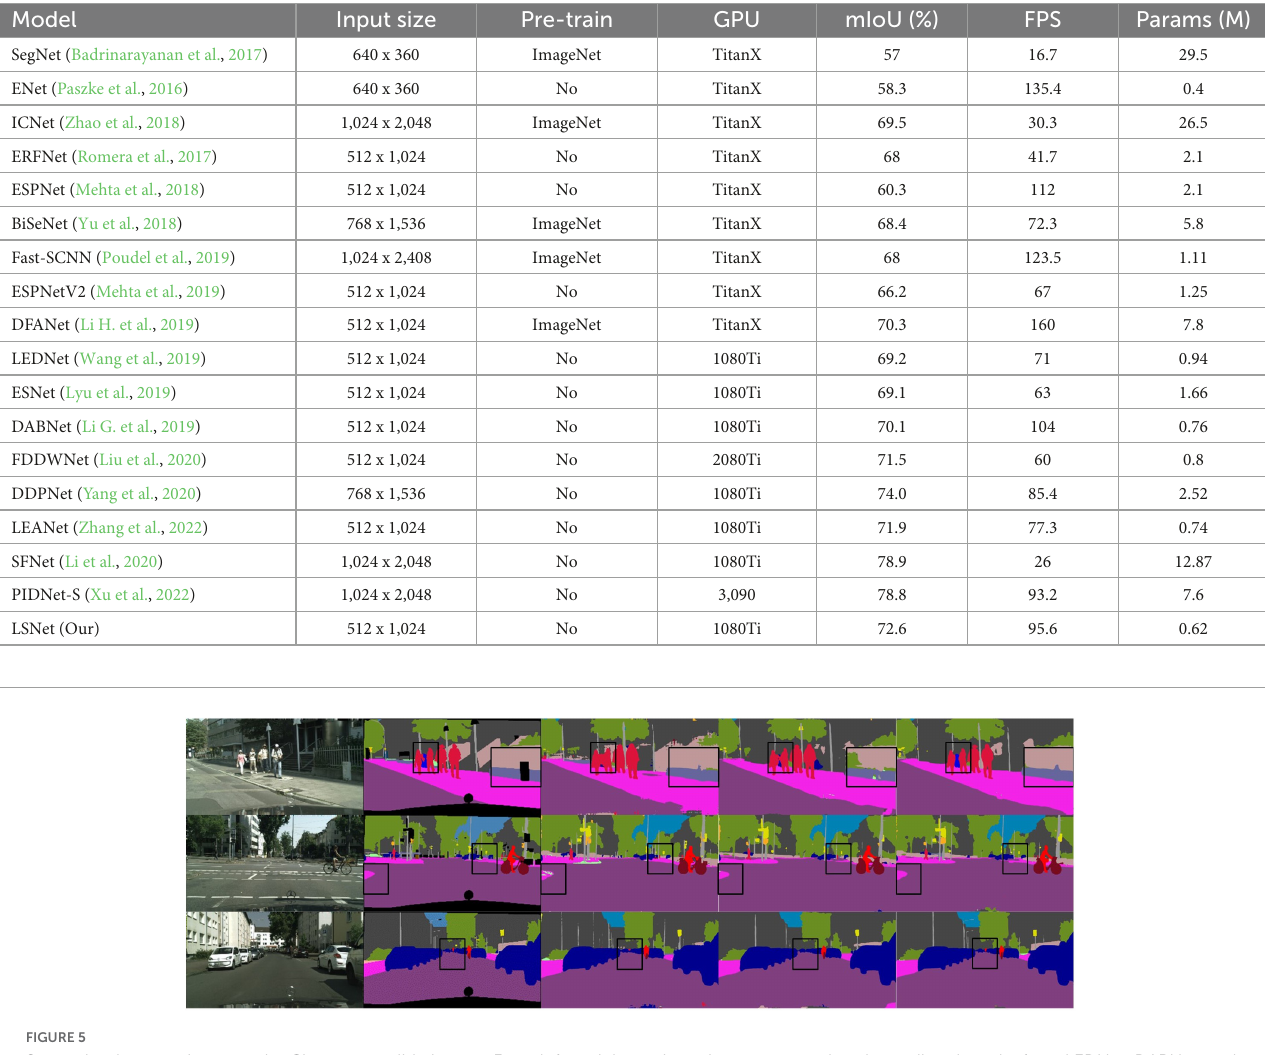
TABLE 4 Evaluation results of our lightweight semantic segmentation network (LSNet) and other state-of-the-art real-time semantic segmentation models on the Cityscapes test set. Model